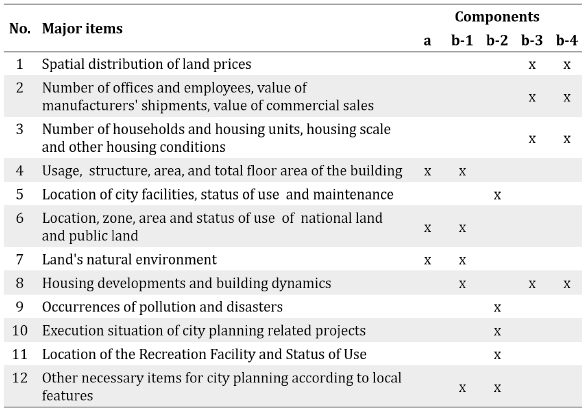
Table 1. Items in the Basic Survey of City Planning in Japan mapped to